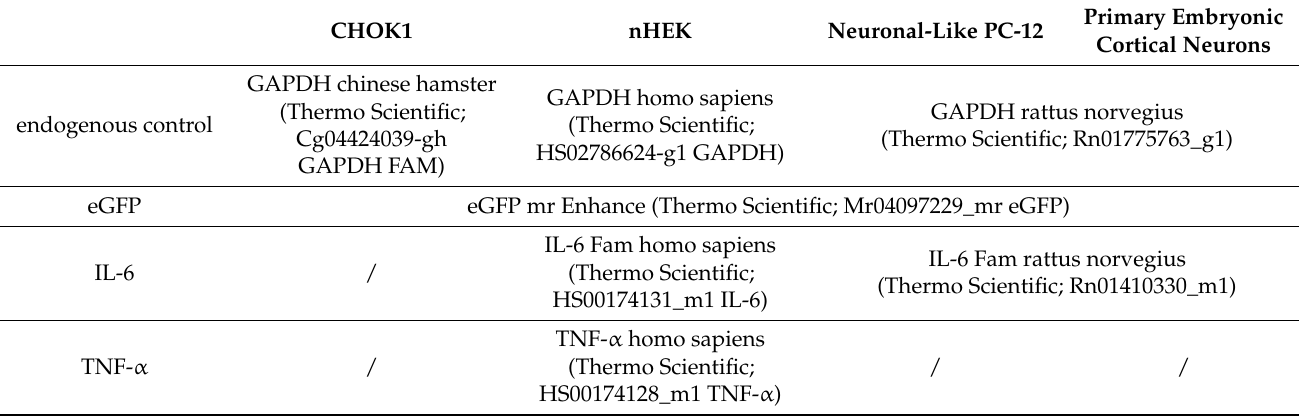
Table 2. qRT-PCR Primers used for all assessed and treated cell lines. Overview of all used qRT-PCR Primers for in vitro and in vivo analysis are listed